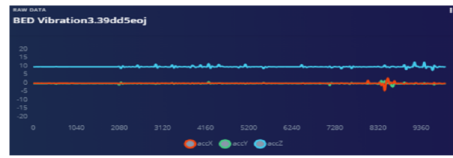
Figure 18. Bed vibration with fixed sensor.